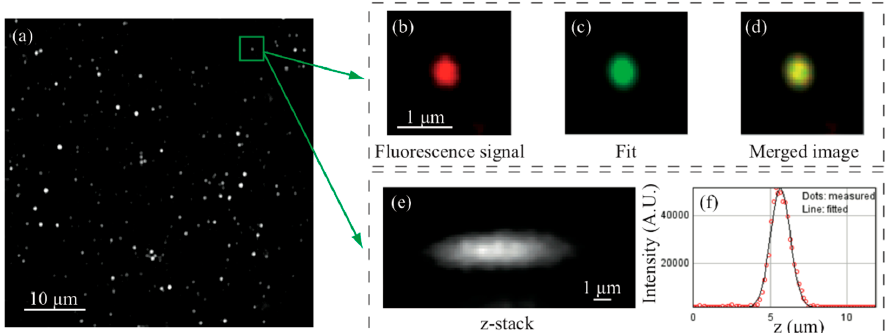
Figure 5. ( a ) Fluorescence signal from the gold nanoparticles, ( b ) one individual gold nanoparticle in red, ( c ) 2D Gaussian fit and ( d ) merged image. ( e ) z-stack reconstruction and ( f ) relative Gaussian fit.